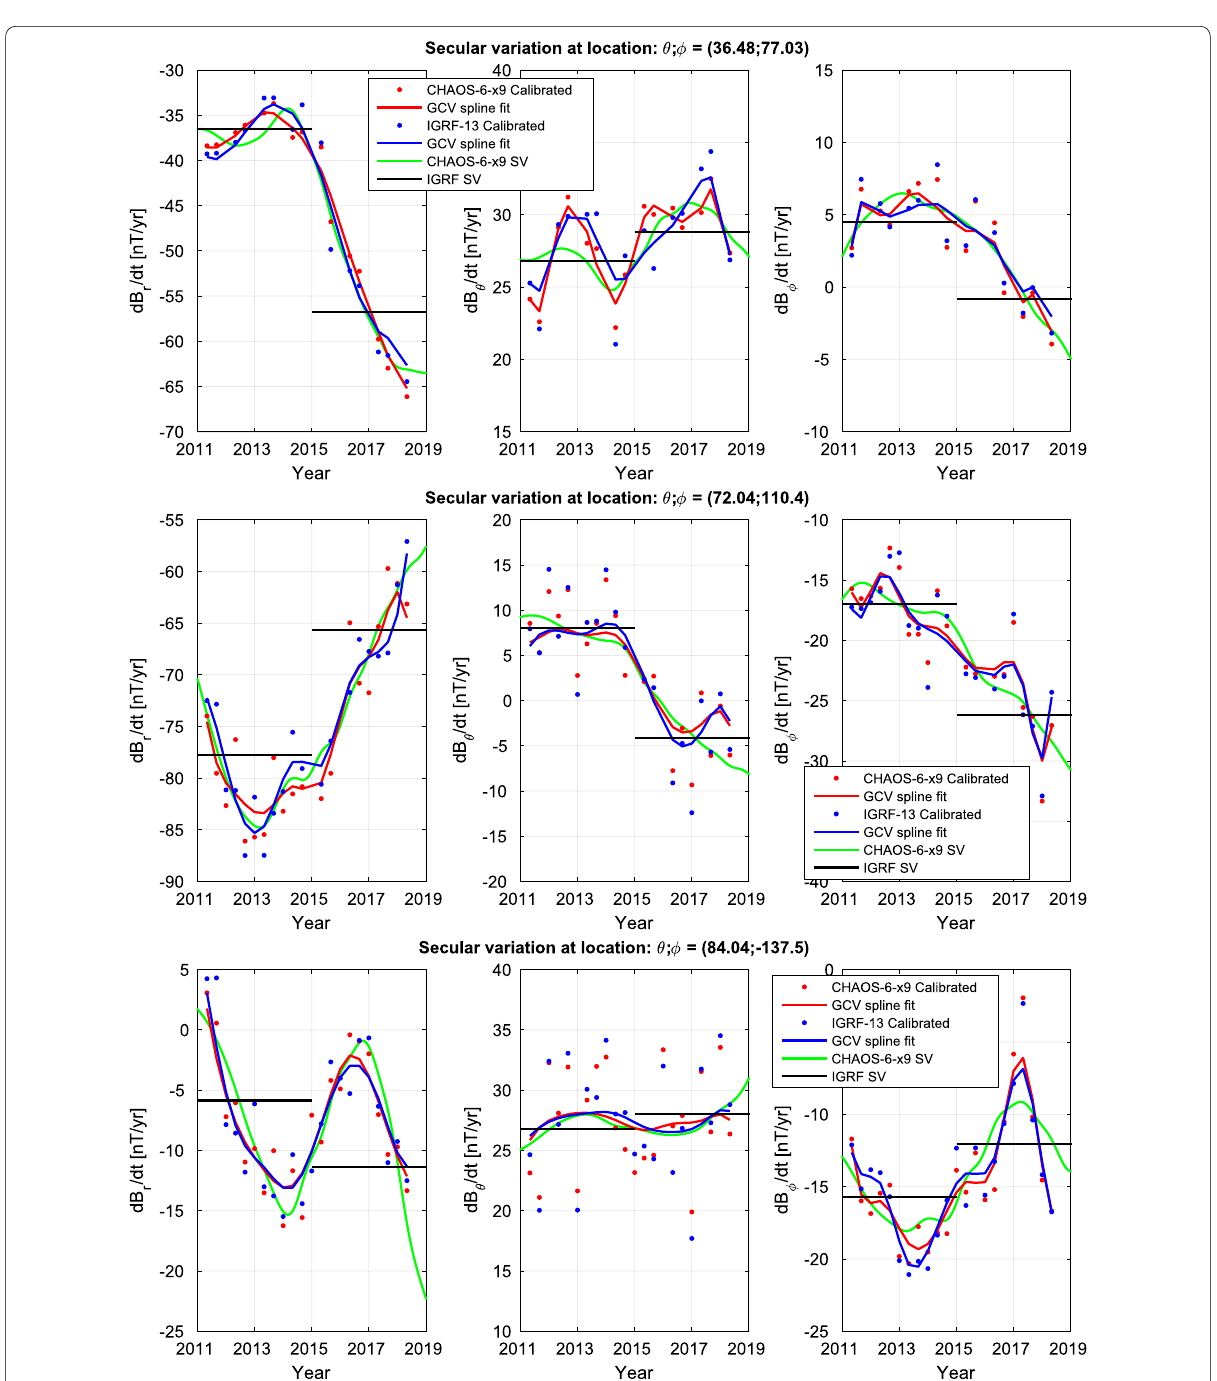
Fig. 2 Time series of annual differences of the spherical polar field components of CryoSat-2 GVO time series derived using CHAOS-6-x9 (red) and IGRF-13 (blue) calibration along with GCV spline fits at the three example grid locations: 26 (top), 100 (center) and 140 (bottom). Also shown are IGRF-13 (black) and CHAOS6-x9 predictions